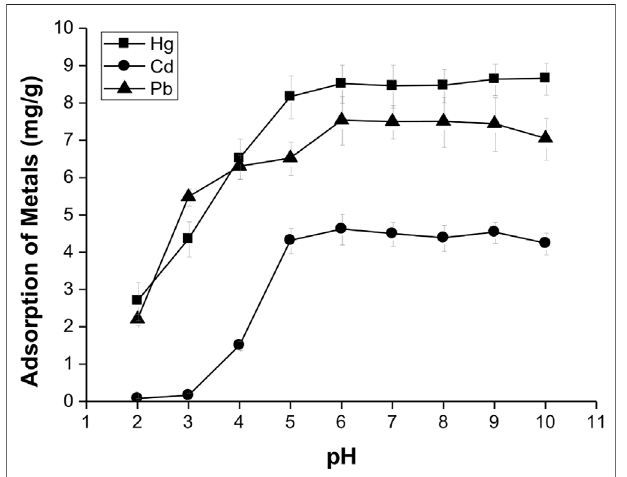
FIGURE 3 | Effect of pH in Pb (II), Cd (II), and Hg (II) adsorption at 51.5 mg L − 1 with Penicillium sp . biomass.